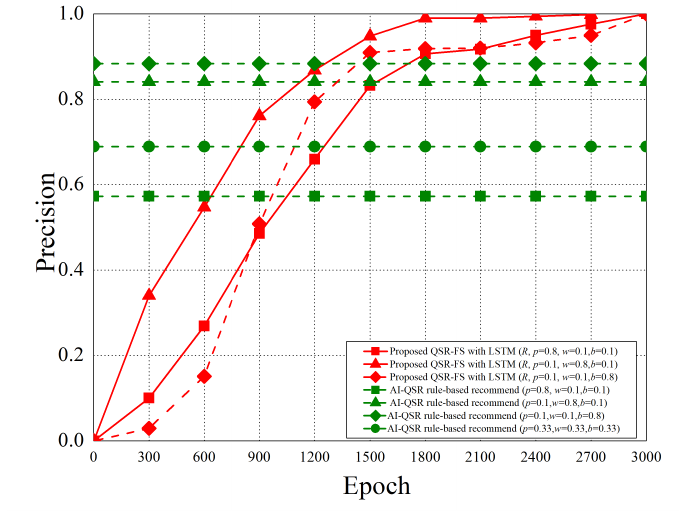
Figure 18. Precision vs. per